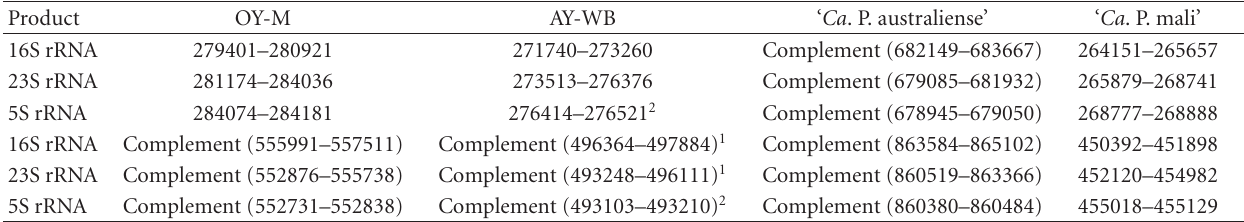
Table 3: Localization of the rRNA